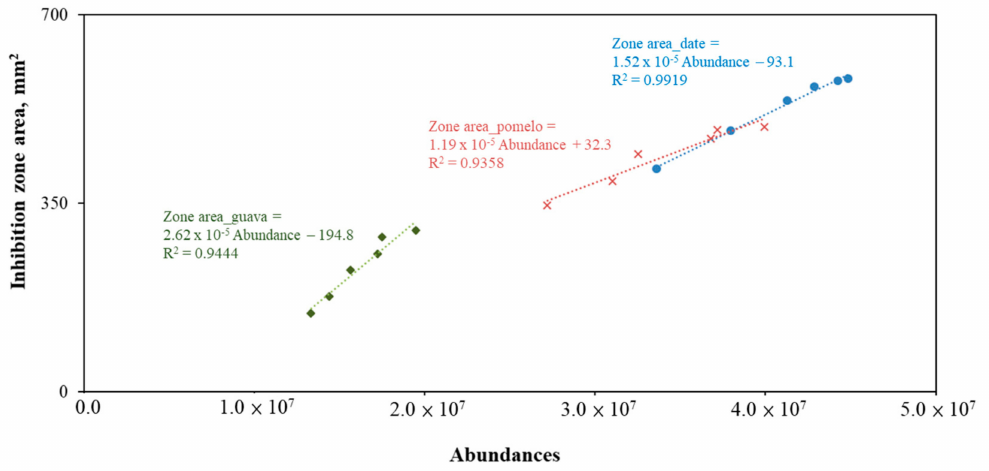
Figure 4. Plot of inhibition zone area versus the abundance of the three SCLs treated at various